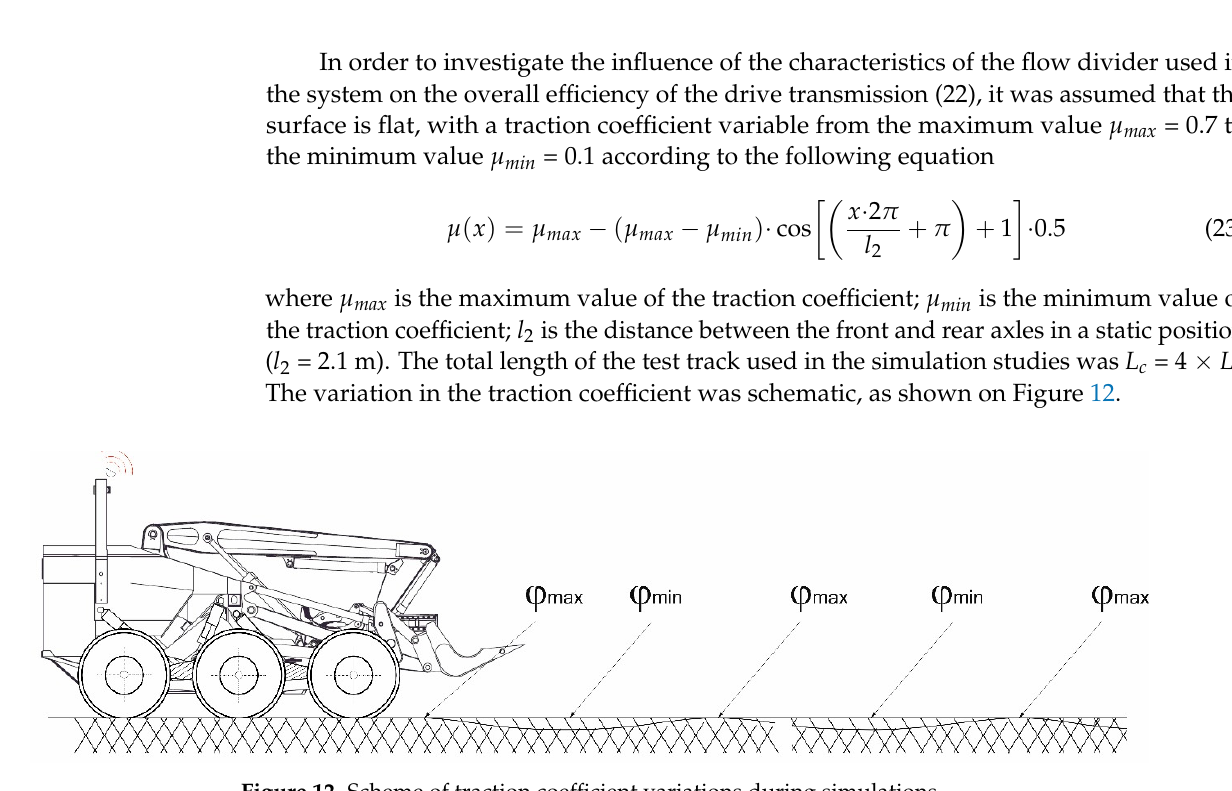
Figure 12. Scheme of traction coefficient variations during simulations.